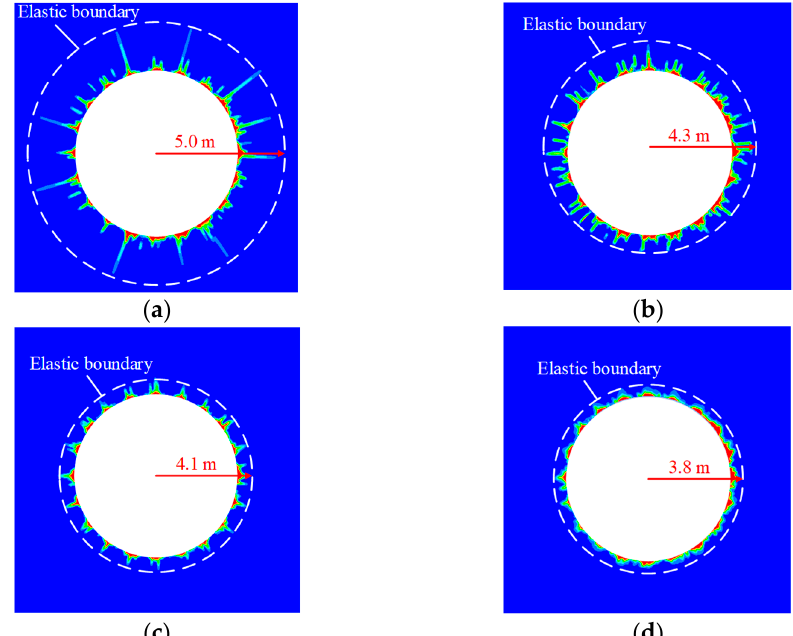
Figure 6. Distributions of the fractured zones caused by blasting under varied hydrostatic in situ stress levels: ( a ) σ x = σ y = 0 MPa; ( b ) σ x = σ y = 10 MPa; ( c ) σ x = σ y = 30 MPa; ( d ) σ x = σ y = 60 MPa.